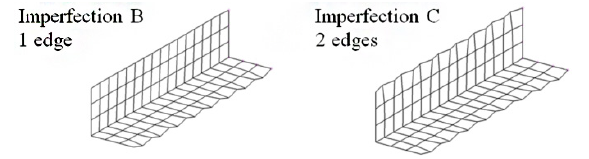
Figure 4. FE models of particular sets of imperfections B and C